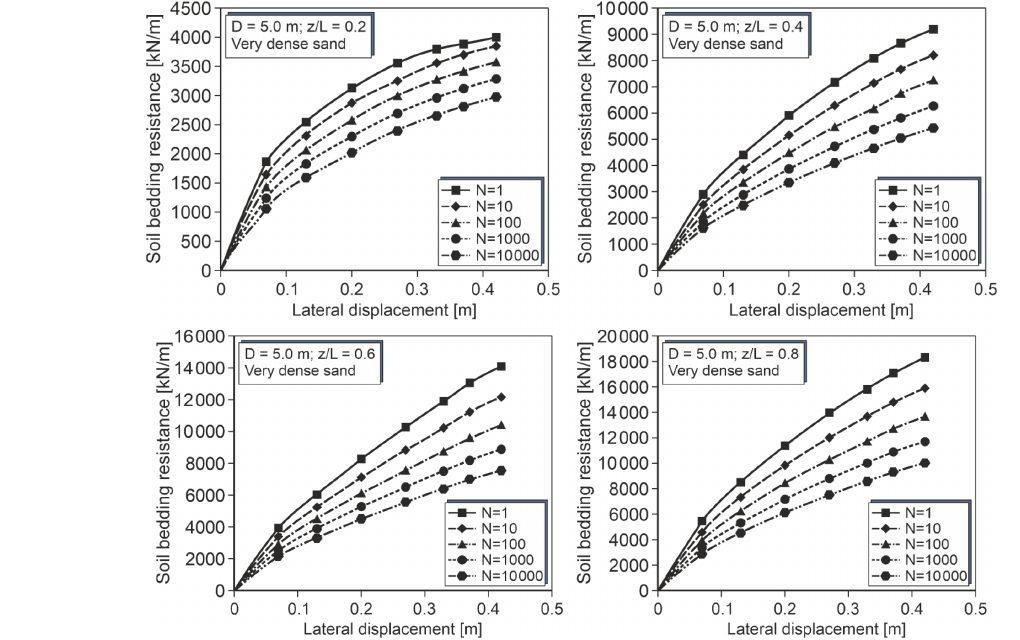
Figure 5. p – y curves for different cycle numbers (monopile D = 5m, L = 25m, very dense sand).